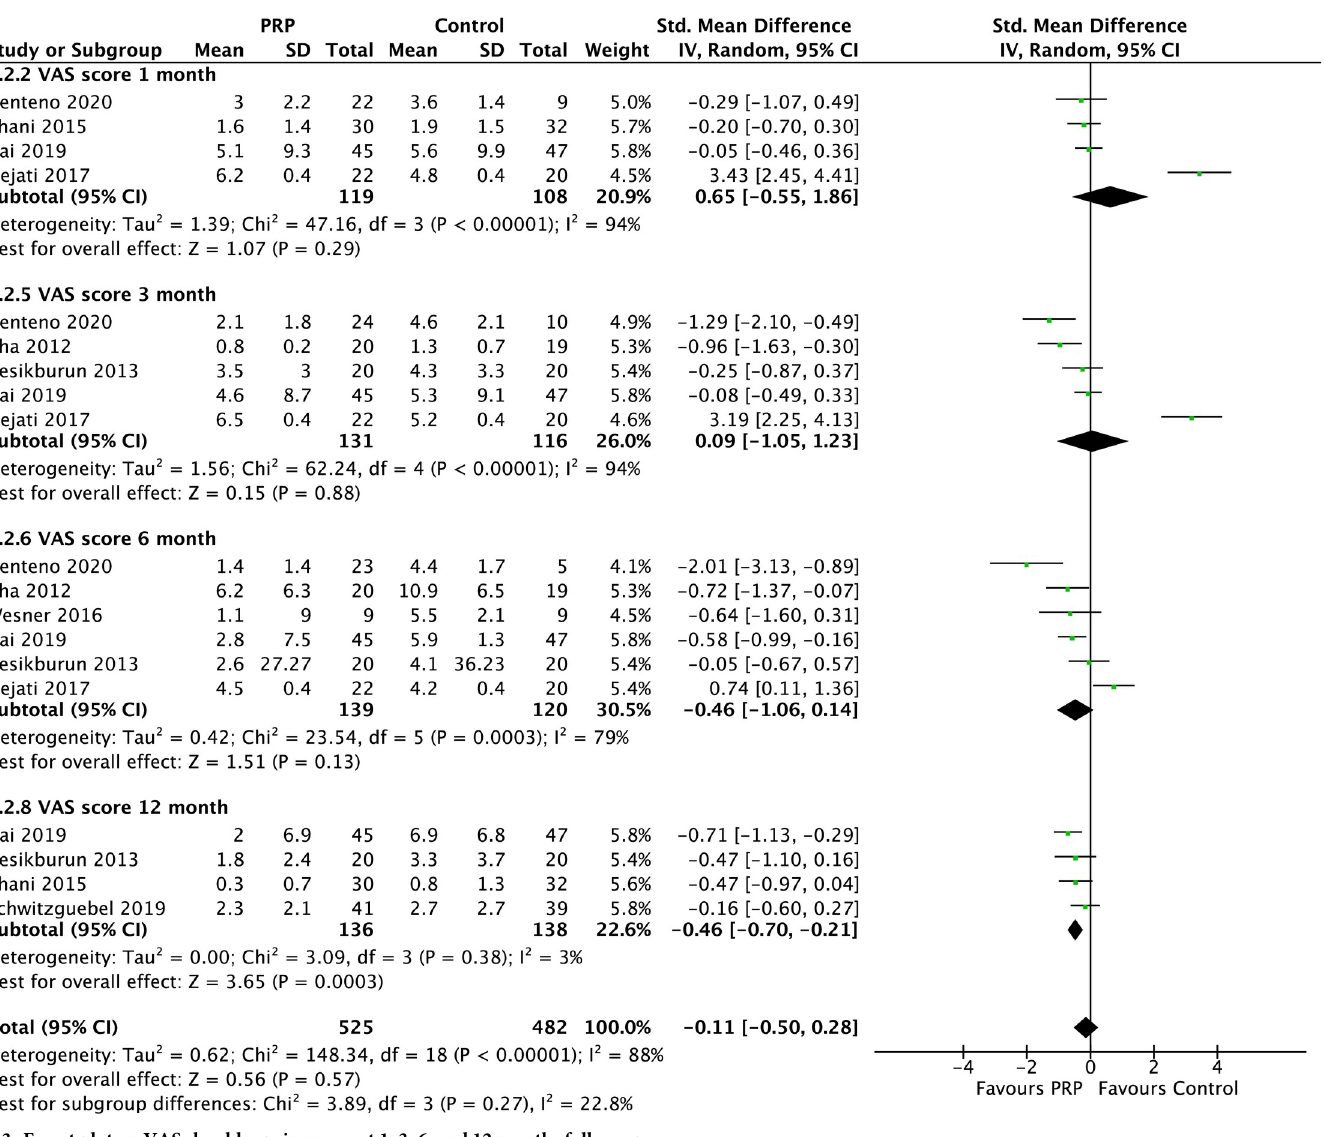
Fig 3. Forest plot on VAS shoulder pain scores at 1, 3, 6, and 12 months